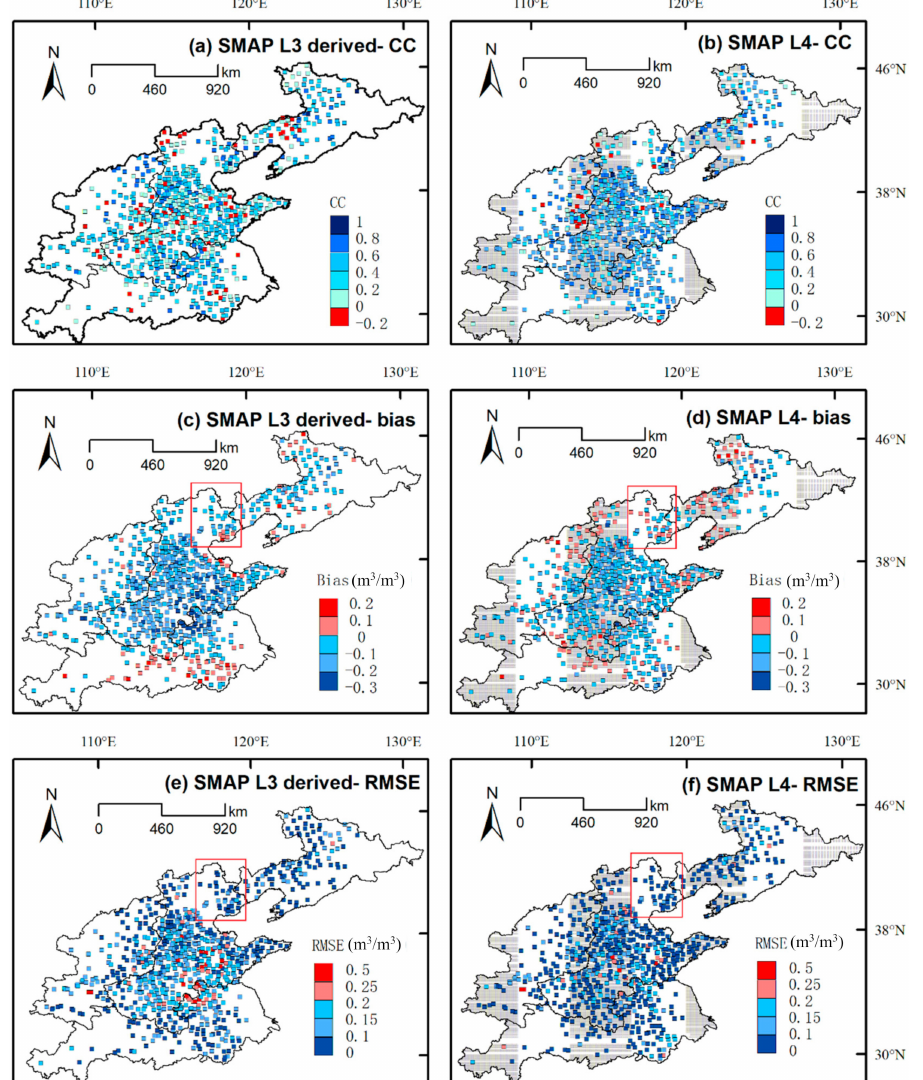
Figure 9. Spatial distribution of CC, bias and RMSE between SMAP L3-derived/SMAP L4-provided RZSM and the observed RZSM series. (Note that the grey box areas in ( b , d , f ) indicate the coverage areas of SMAP L4 product at 00:00 UTC, when the ground RZSM was observed). Additionally, one typical area located in the northern part of Haihe River basin in China was zoomed in from the spatial error map (Figures 9 and 10). Larger estimation errors and uncertainties were found in those Cropland areas, where the underlying surface are strongly perturbed by complex human activities, e.g., mining groundwater, agricultural irrigation, which may largely influence the supply and transport conditions of soil